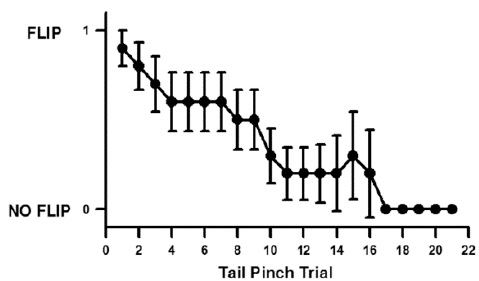
Figure 2. Habituation rate in tail flipping for shrimp (Belize cohort) with repetitive pinching on the telson every 30 s. On average (average +/− SEM) the animals could be pinched 16 times before habituating (30.5 °C). Ten individual shrimp were used (average +/− SEM). FLIP is a tailflip and NO FLIP is when no tail flip is observed.